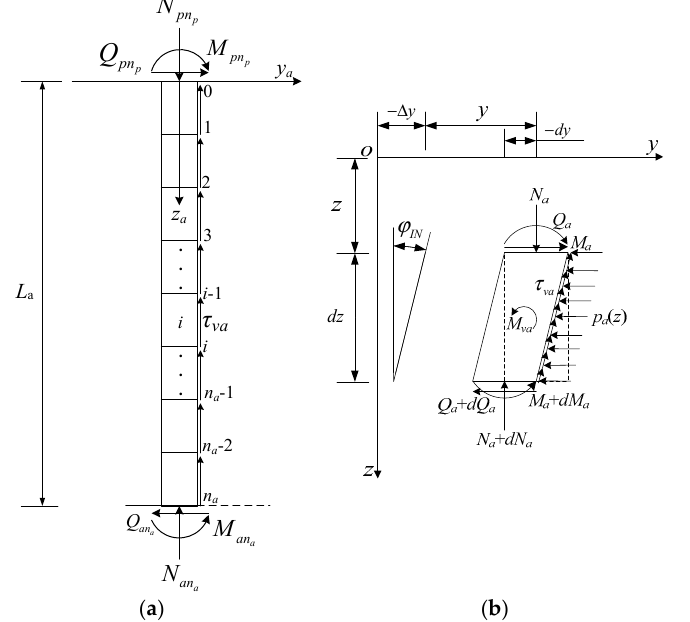
Figure 6. Discretization for active segment and element analysis for a segment. ( a ) Discretization for active segment. ( b ) Element analysis for a segment.